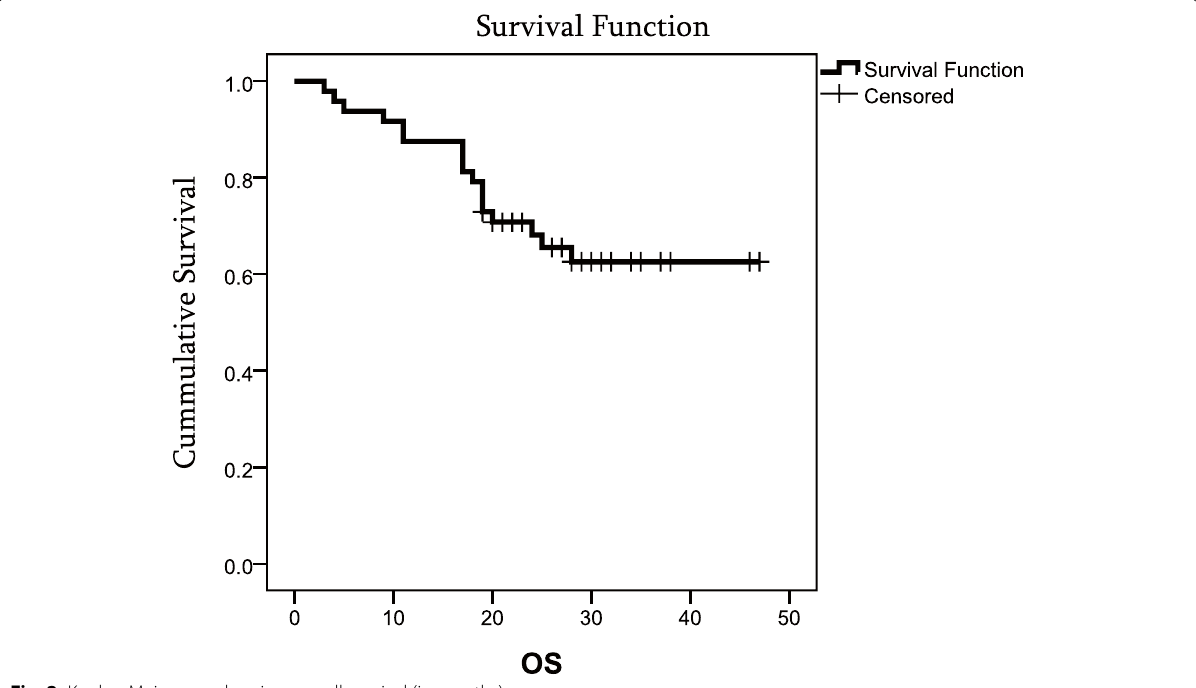
Fig. 2 Kaplan-Meir curve showing overall survival (in